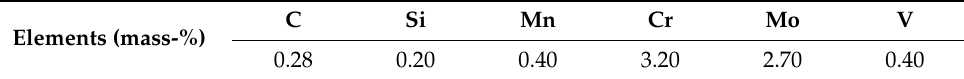
Table 1. Chemical composition of hot-work tool steel AISI H10 powder according to the manufac- turer’s specifications [23] and verification of the data in our own laboratory tests with combustion analysis and X-ray fluorescence